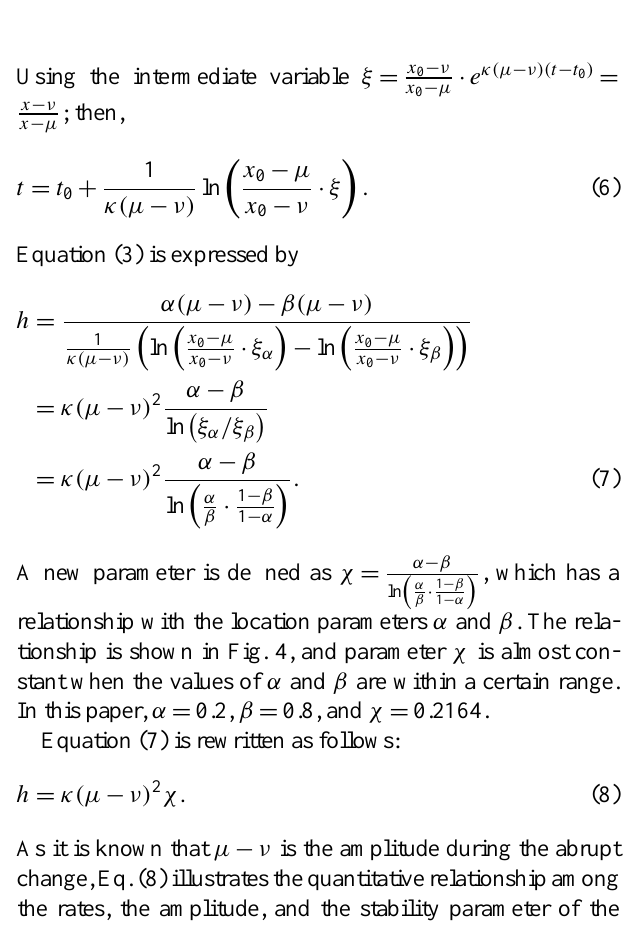
Figure 2. The evolution of the system over time, with different stability parameters: (a) the system reaches to the stable states with a different initial variable when parameter κ =± 0.01; (b) the system becomes bifurcated when the parameter κ = 105; (c) the system becomes chaotic when the parameter κ = 135.